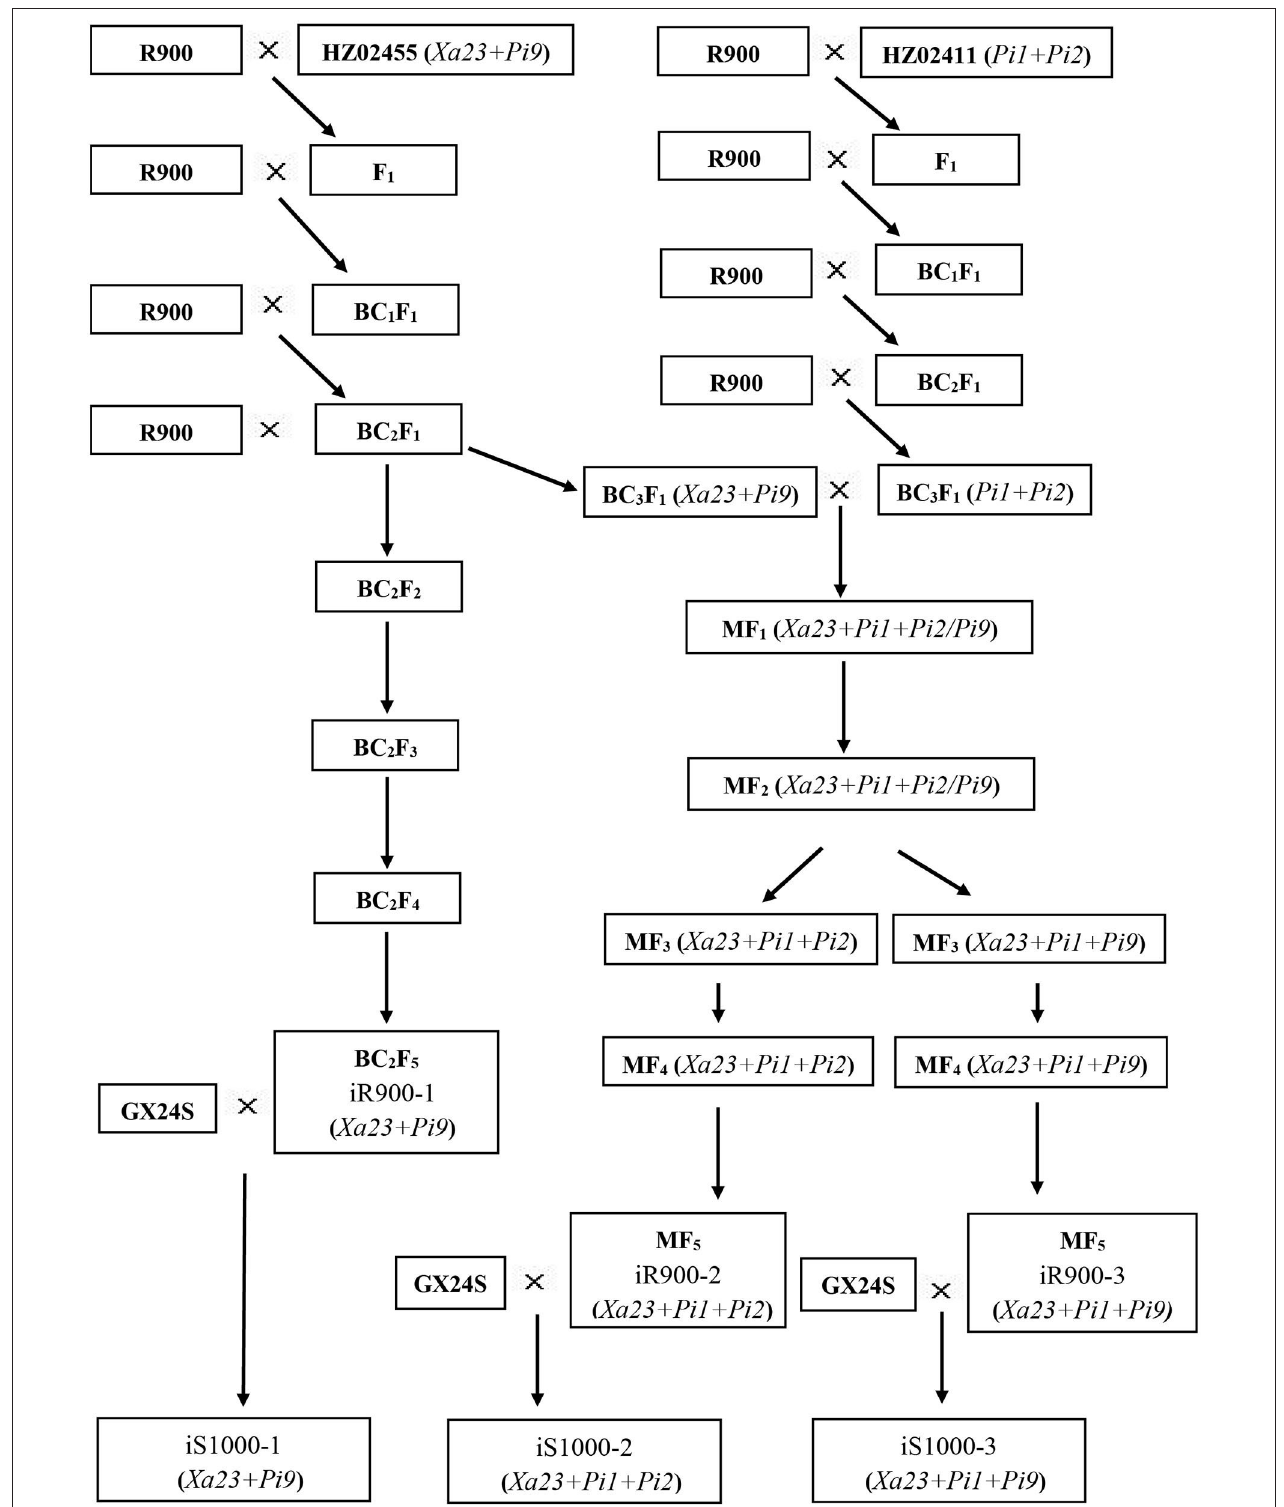
FIGURE 1 | The scheme for development of the iR900 lines and iS1000 hybrids.